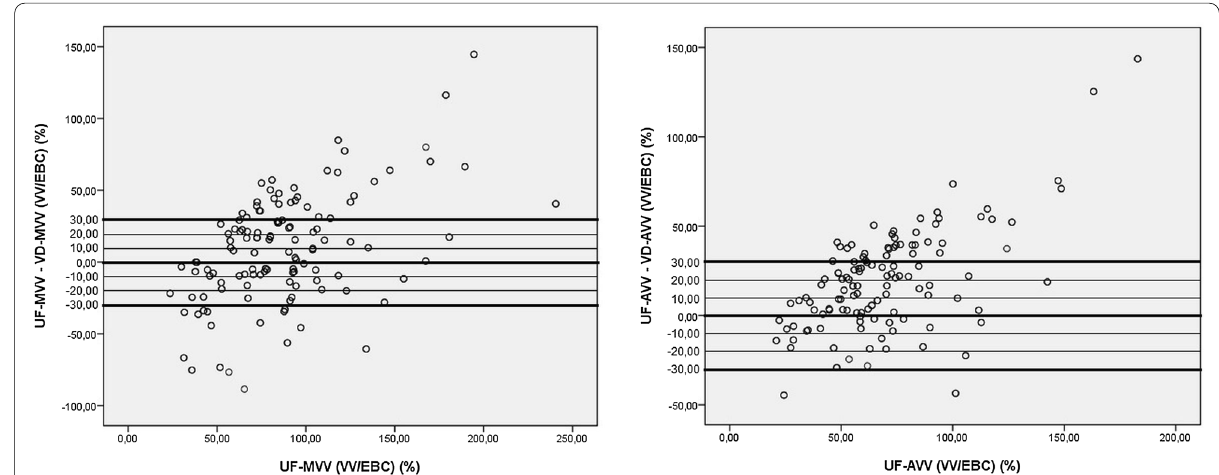
Fig. 1 Bland–Altman plot. MVV: maximum voided volume, AVV: average voided volume, UF: uroflowmetry, VD: voiding diary, VV: voided volume, EBC: estimated bladder